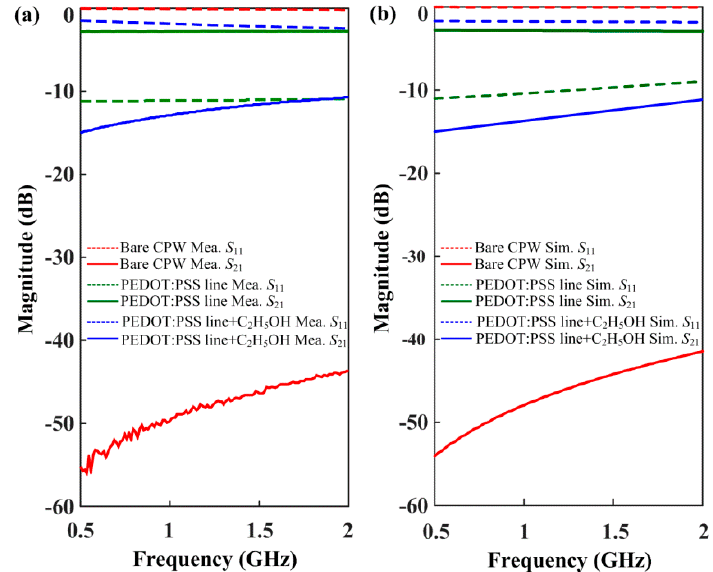
Figure 4. Magnitude of S-parameters in the three sample configurations; ( a ) Measured; ( b ) Simulated samples.